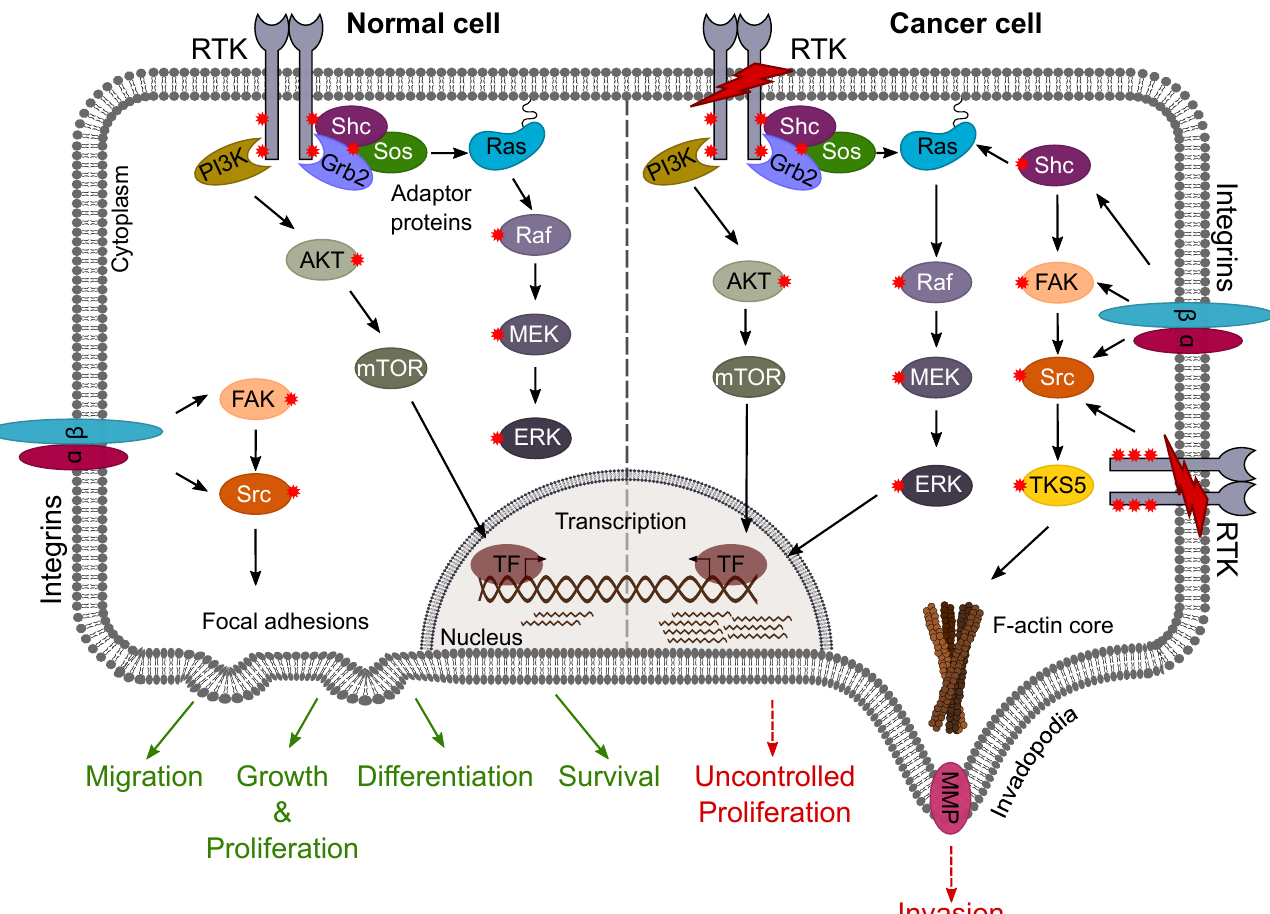
Figure 5. Simplified schematic illustration of common RTK signaling pathways in normal and cancer cells. In normal cells, ligand binding (or integrin-mediated adhesion signals) induces receptor dimerization and tyrosine phosphorylation (red asterisks). Activated RTKs in turn initiate signaling cascades such as the RAS/MAPK, PI3K/Akt/mTOR, or FAK/Src pathways through recruitment of adaptor proteins Grb2 and Shc. This results in cellular responses such as survival, growth, proliferation, differentiation, and migration (left; depicted in green). In cancer cells, overexpression, mutation, or amplification of RTKs can lead to an oncogenic phenotype by activation of invasion pathways as well as uncontrolled proliferation (right; shown in